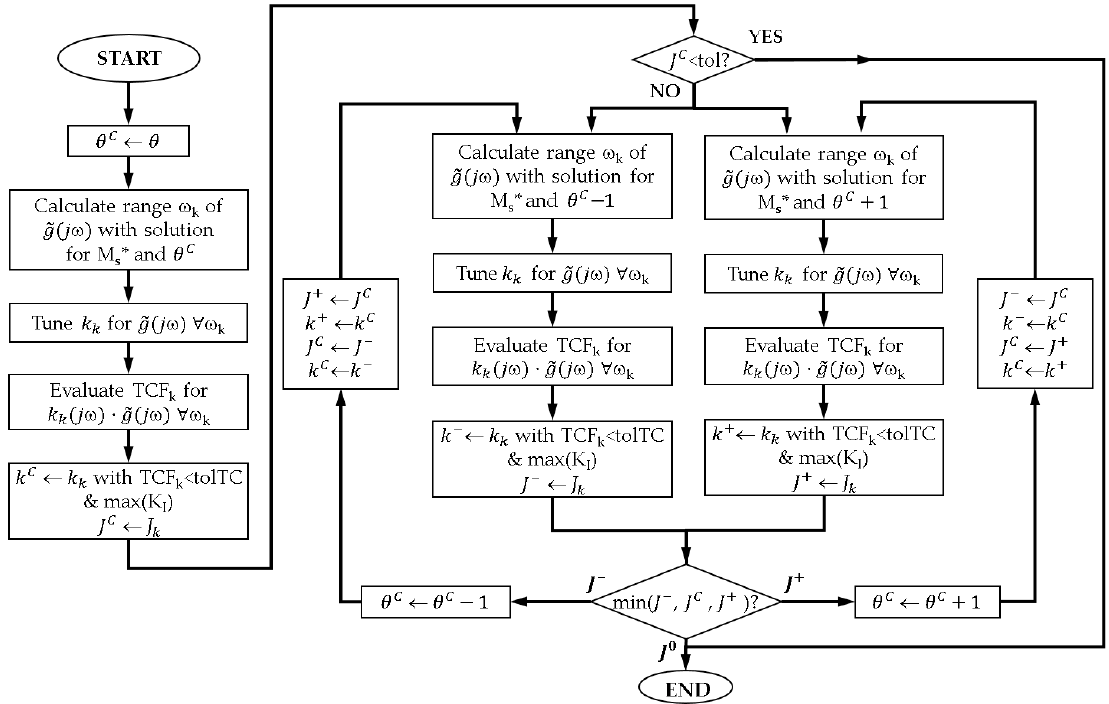
Figure 6. Flow diagram of the proposed SISO PID tuning algorithm for a specified sensitivity margin.